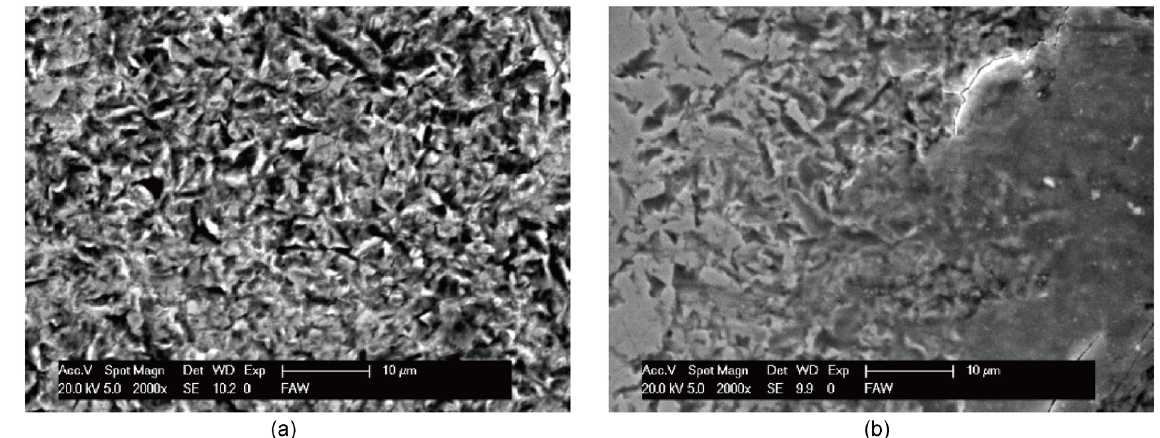
Fig. 7 SEM images of the piston ring under dry sliding conditions with CNTs: (a) before the tribological testing, and (b) after the tribological testing.